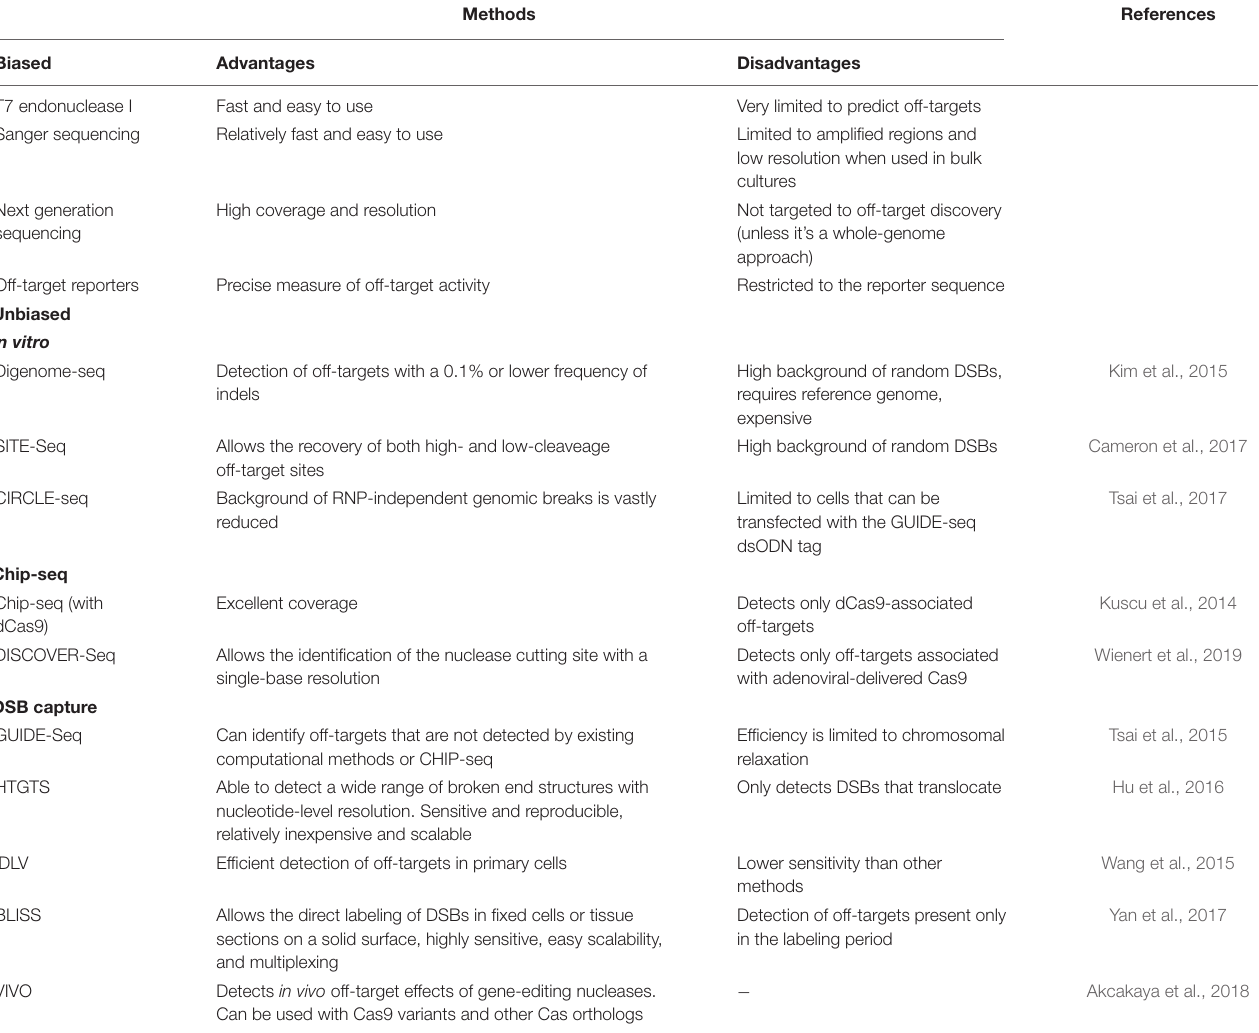
TABLE 1 | Summary table of the methods currently available to detect off-target activity in gene editing